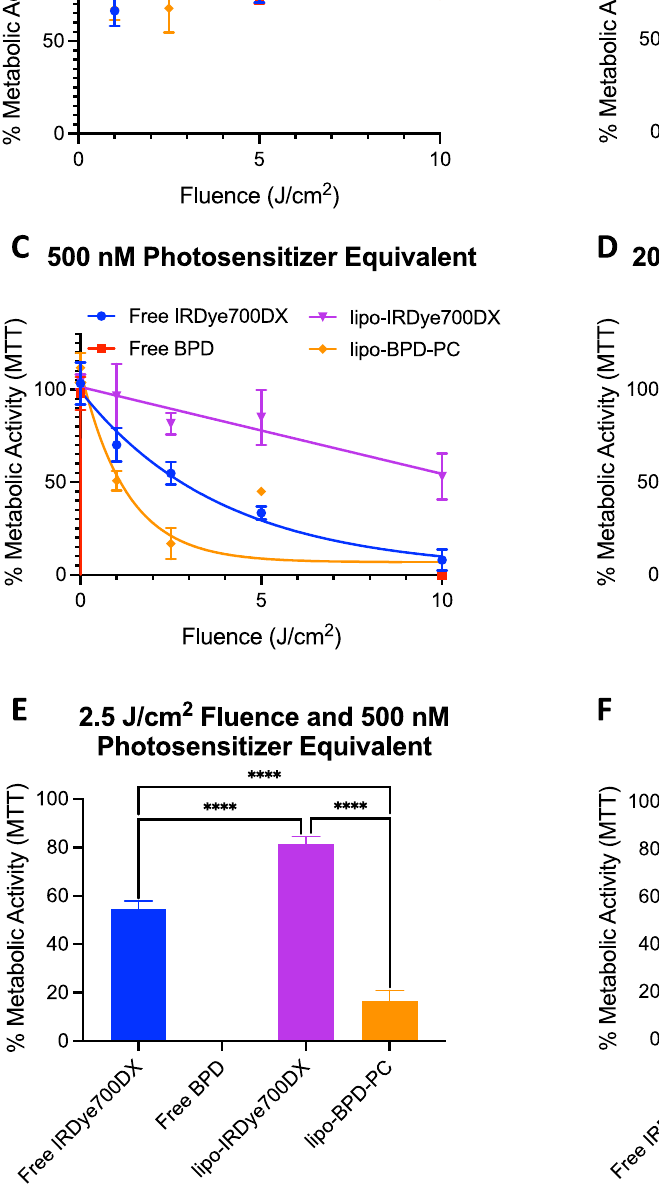
Figure 8: Percent metabolic activity of FaDu cells as determined by the MTT assay performed 48 h following PDT with lipo-IRDye700DX, lipo- BPD-PC, and free PS